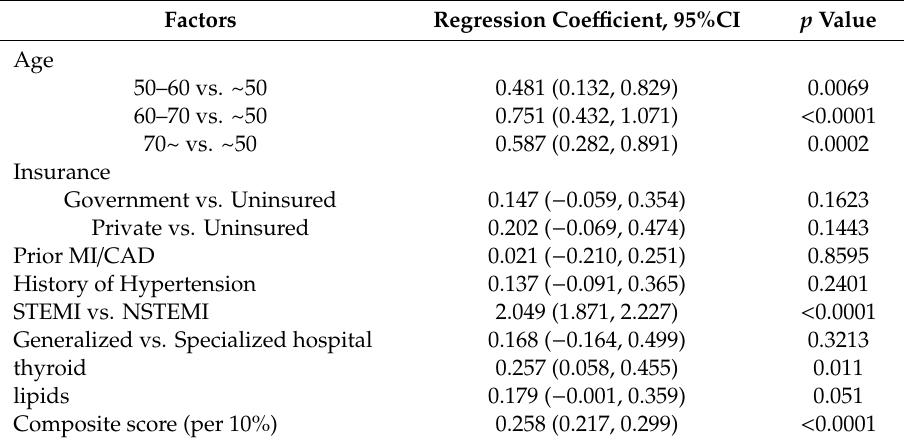
Table 6. E ff ect of patient composite scores on length of